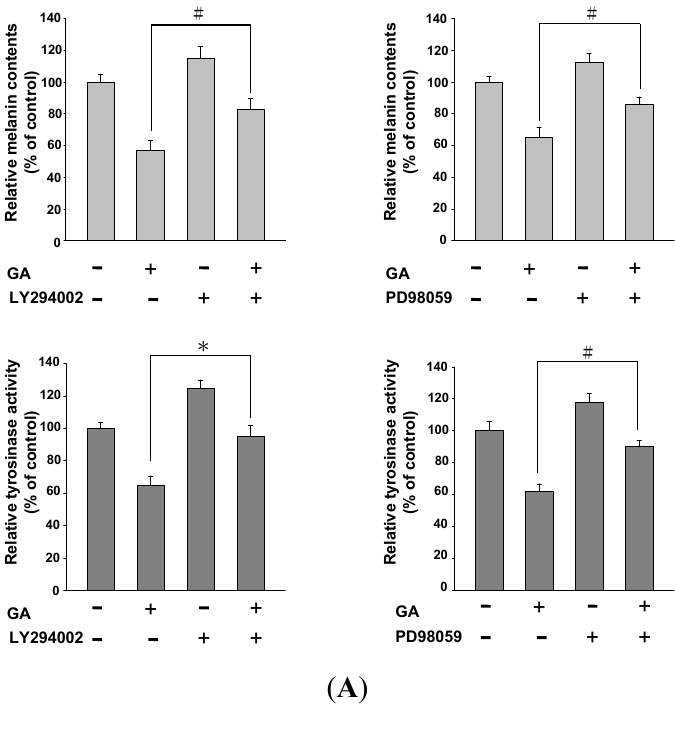
Figure 5. Recovery effect of co-treatment with PI3K/Akt or MEK/ERK specific inhibitors and gallic acid on cellular melanin content, cellular tyrosinase activity and melanogenesis-related proteins expression in B16F10 cells. Cells were pretreated with (or without) 20 μ M MEK/ERK inhibitor (PD98059) or PI3K/Akt inhibitor